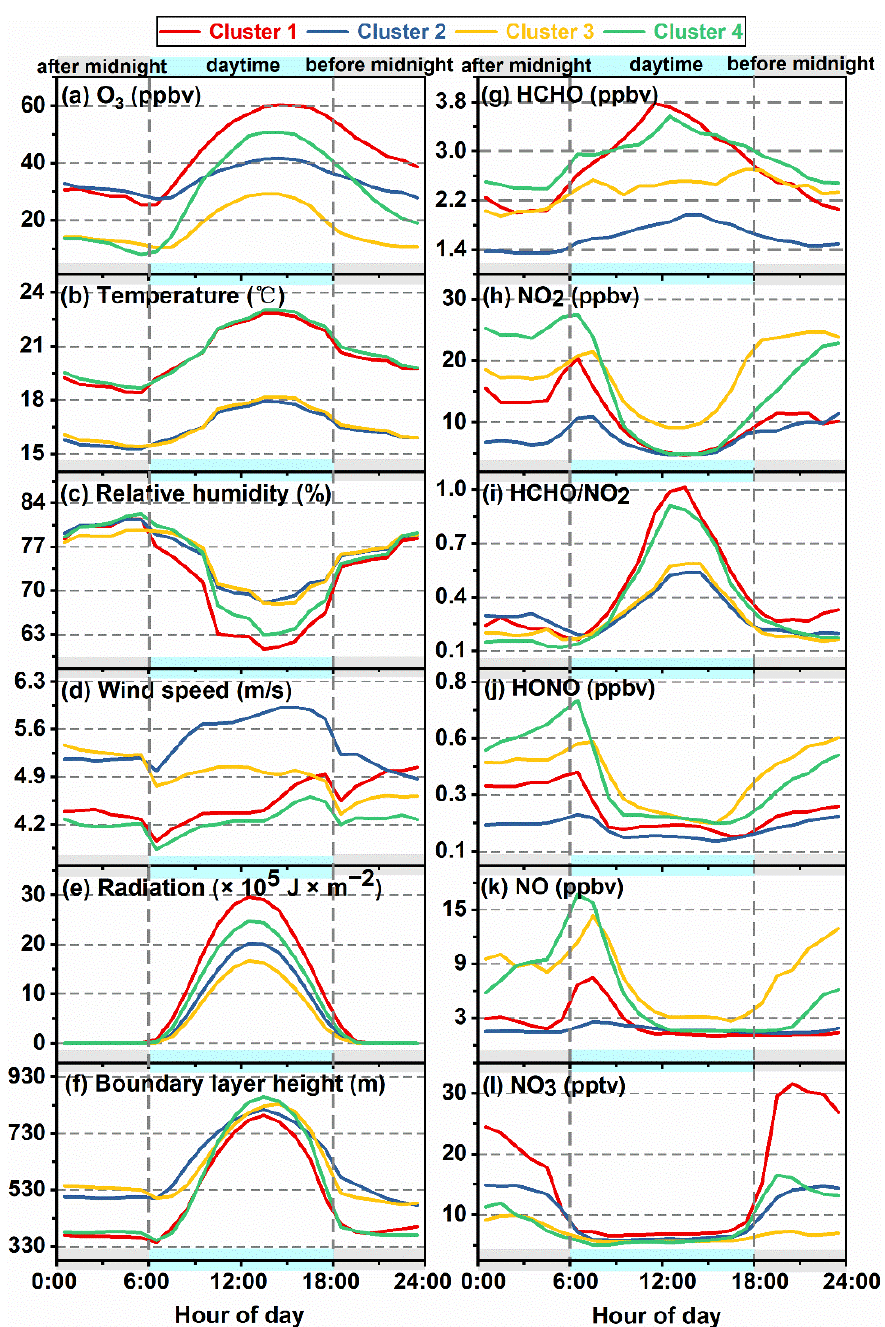
Figure 6. Diurnal variations in O 3 ( a ) and the meteorological factors (temperature ( b ), relative humidity ( c ), wind speed ( d ), radiation ( e ), and boundary layer height ( f )) as well as the relevant atmospheric components (HCHO ( g ), NO 2 ( h ), HCHO/NO 2 ( i ), HONO ( j ), NO ( k ), and NO 3 ( l )). Table 1. A summary of the information visualized in Figure 6 for the four clusters in different peri- ods.